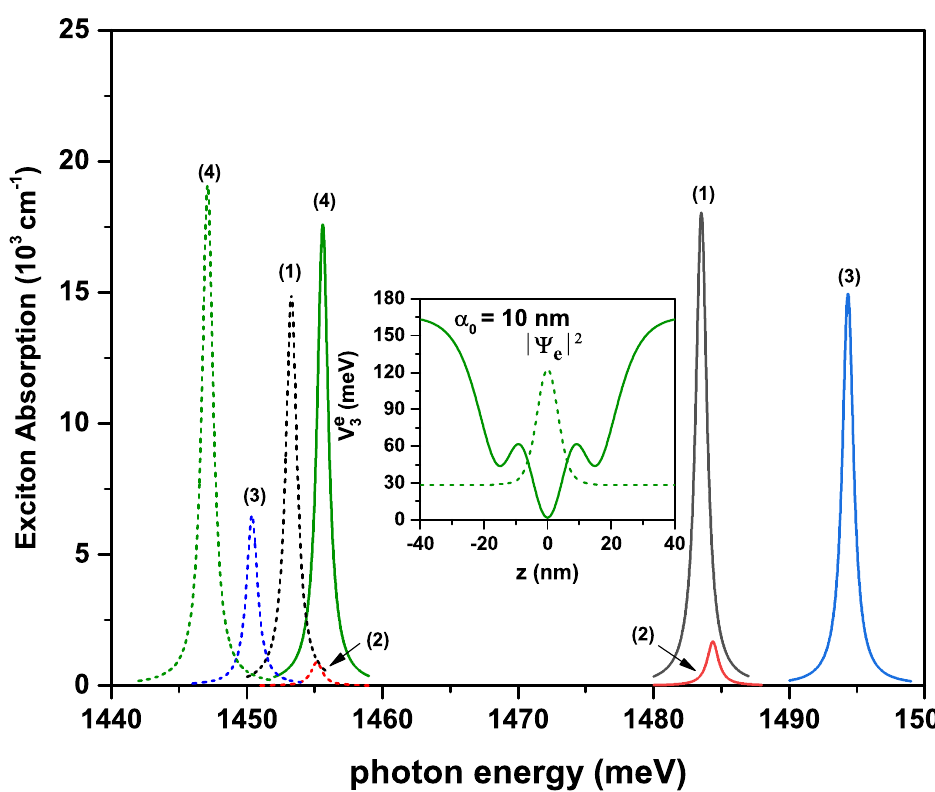
Figure 6. Exciton absorption coefficients for interband transitions as a function of the incident photon energy for confinement potential V 3 ( z e ( h ) ) with ν 3 = 4. Several combinations of the fields ( F , B , α 0 ) (with F in kV/cm, B in Tesla, and α 0 in nm) were considered and are indicated by labels 1, 2, 3, and 4: (0,0,0) (1), (25,0,0) (2), (0,10,0) (3), and (0,0,10) (4). Solid lines are for L ef f = 30nm, whereas dashed lines are for L ef f = 50nm. The inset shows the changes in the confinement potentials and the square of the electron ground state wavefunction for α 0 =